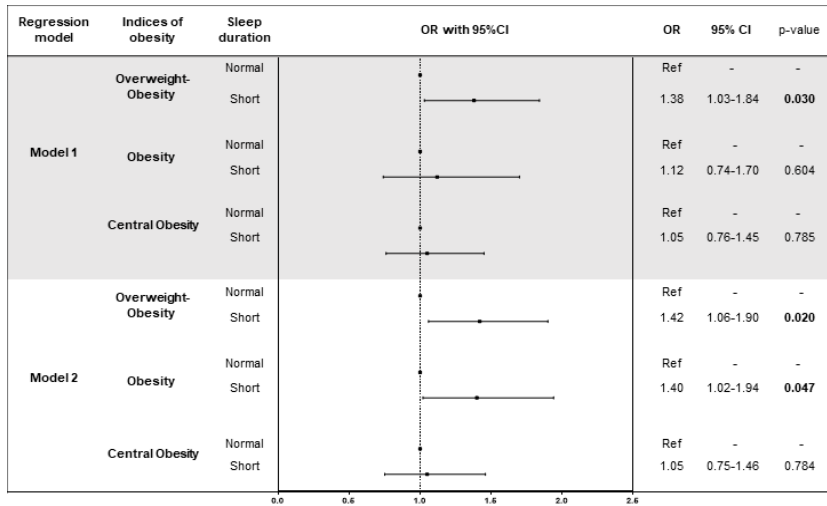
Figure 1. Logistic regression models of the association between sleep duration and indices of obesity. Model 1 was adjusted for age, sex, smoking status, marital status, employment, risk of sleep apnoea, medical history and treatments (diabetes, hypertension and hyperlipidaemia). Model 2 was adjusted for age, sex, smoking status, marital status, employment, medical history and treatments (diabetes, hypertension and hyperlipidaemia), diet, total energy intake and physical activity.